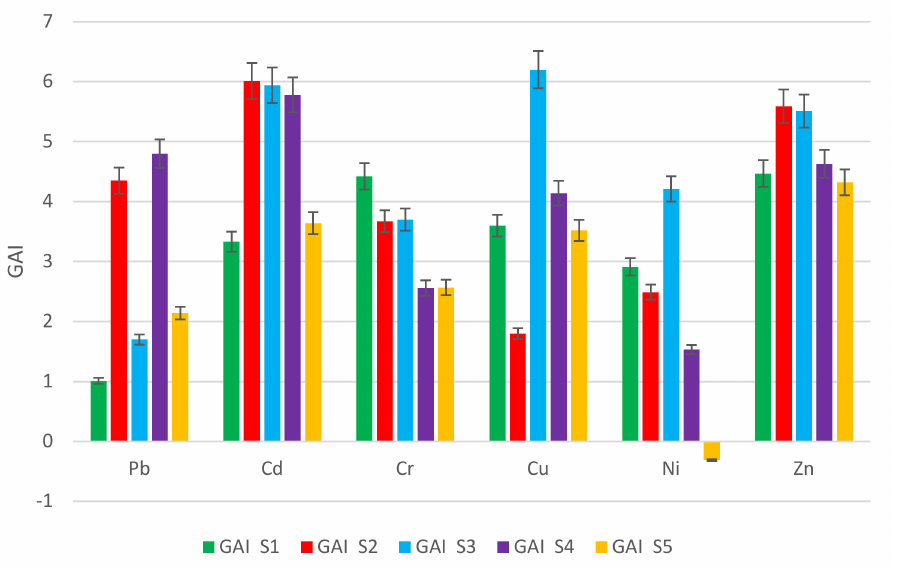
Figure 2. The geoaccumulation index (GAI) of HMs in